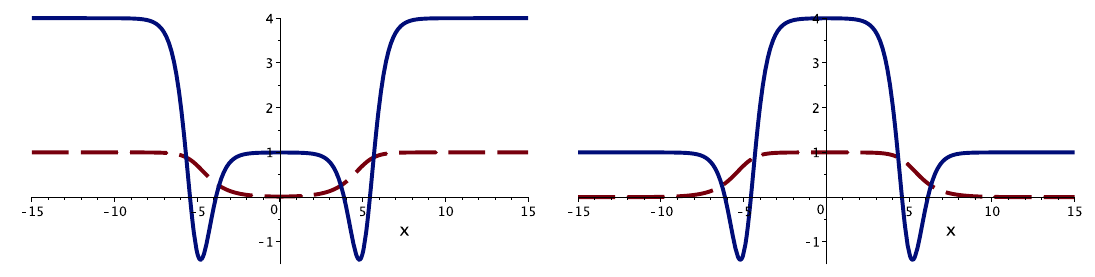
Figure 3 . The φ 6 model on the full line: Schr¨odinger-like potential (solid line) and scalar field profile (traced line) for a) (left) antikink-kink (composite system Φ 1+ ( x (right) kink-antikink (composite system Φ 1+ ( x